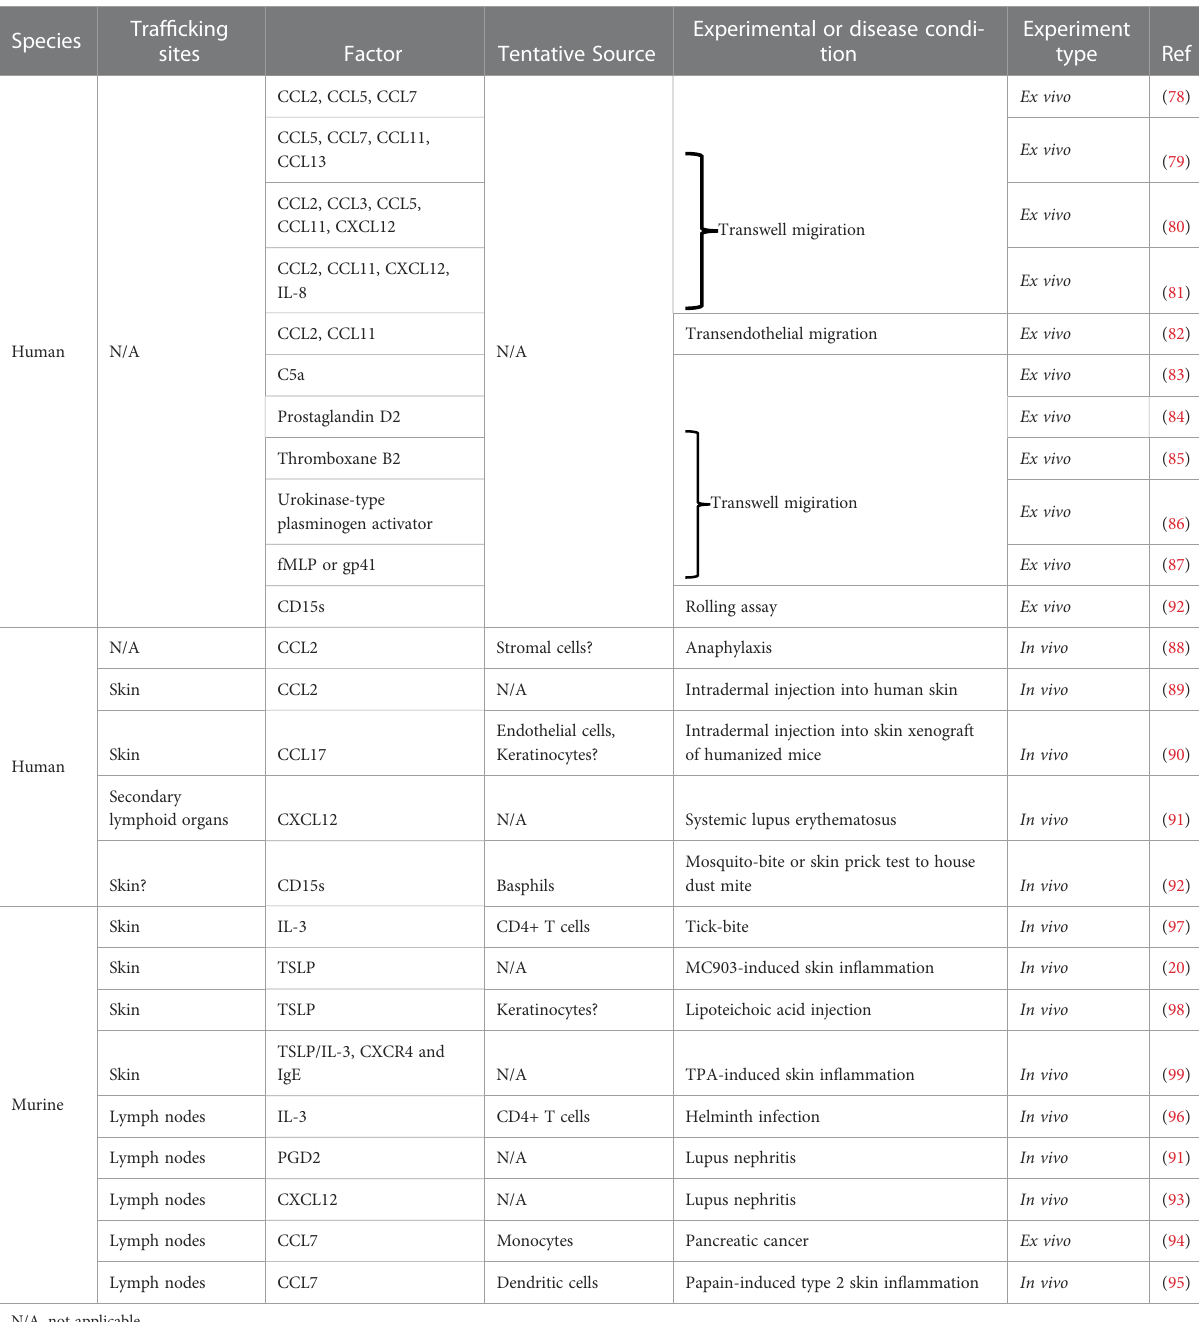
TABLE 1 In vivo or ex vivo evidence for basophil traf fi cking to tissues.